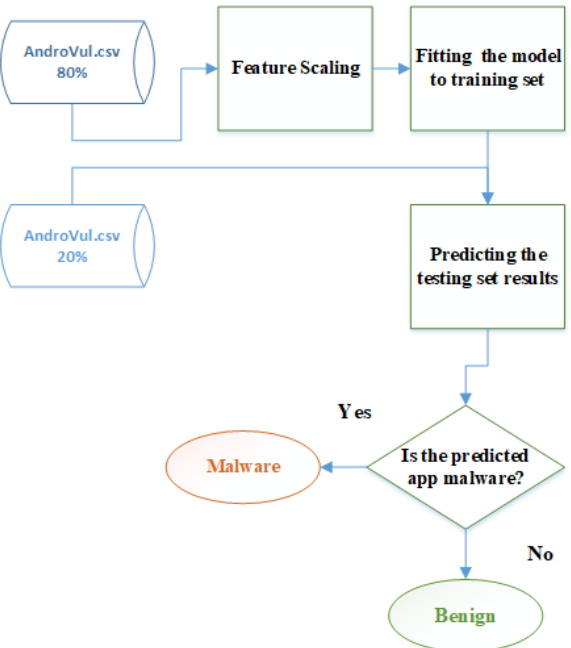
Figure 4. Design Methodology for malware detection in